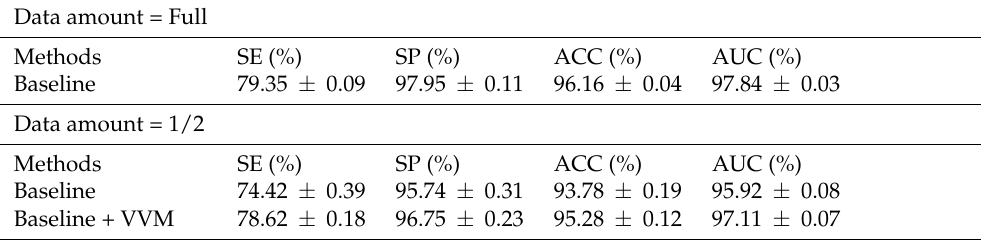
Table 4. Statistical comparison of the effectiveness of the VQ-VAE